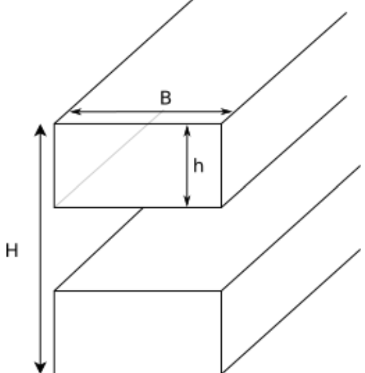
Figure 3. Assumed spar-cap structure with dimensions: H is the total build height, h is the space between planks and B is the plank